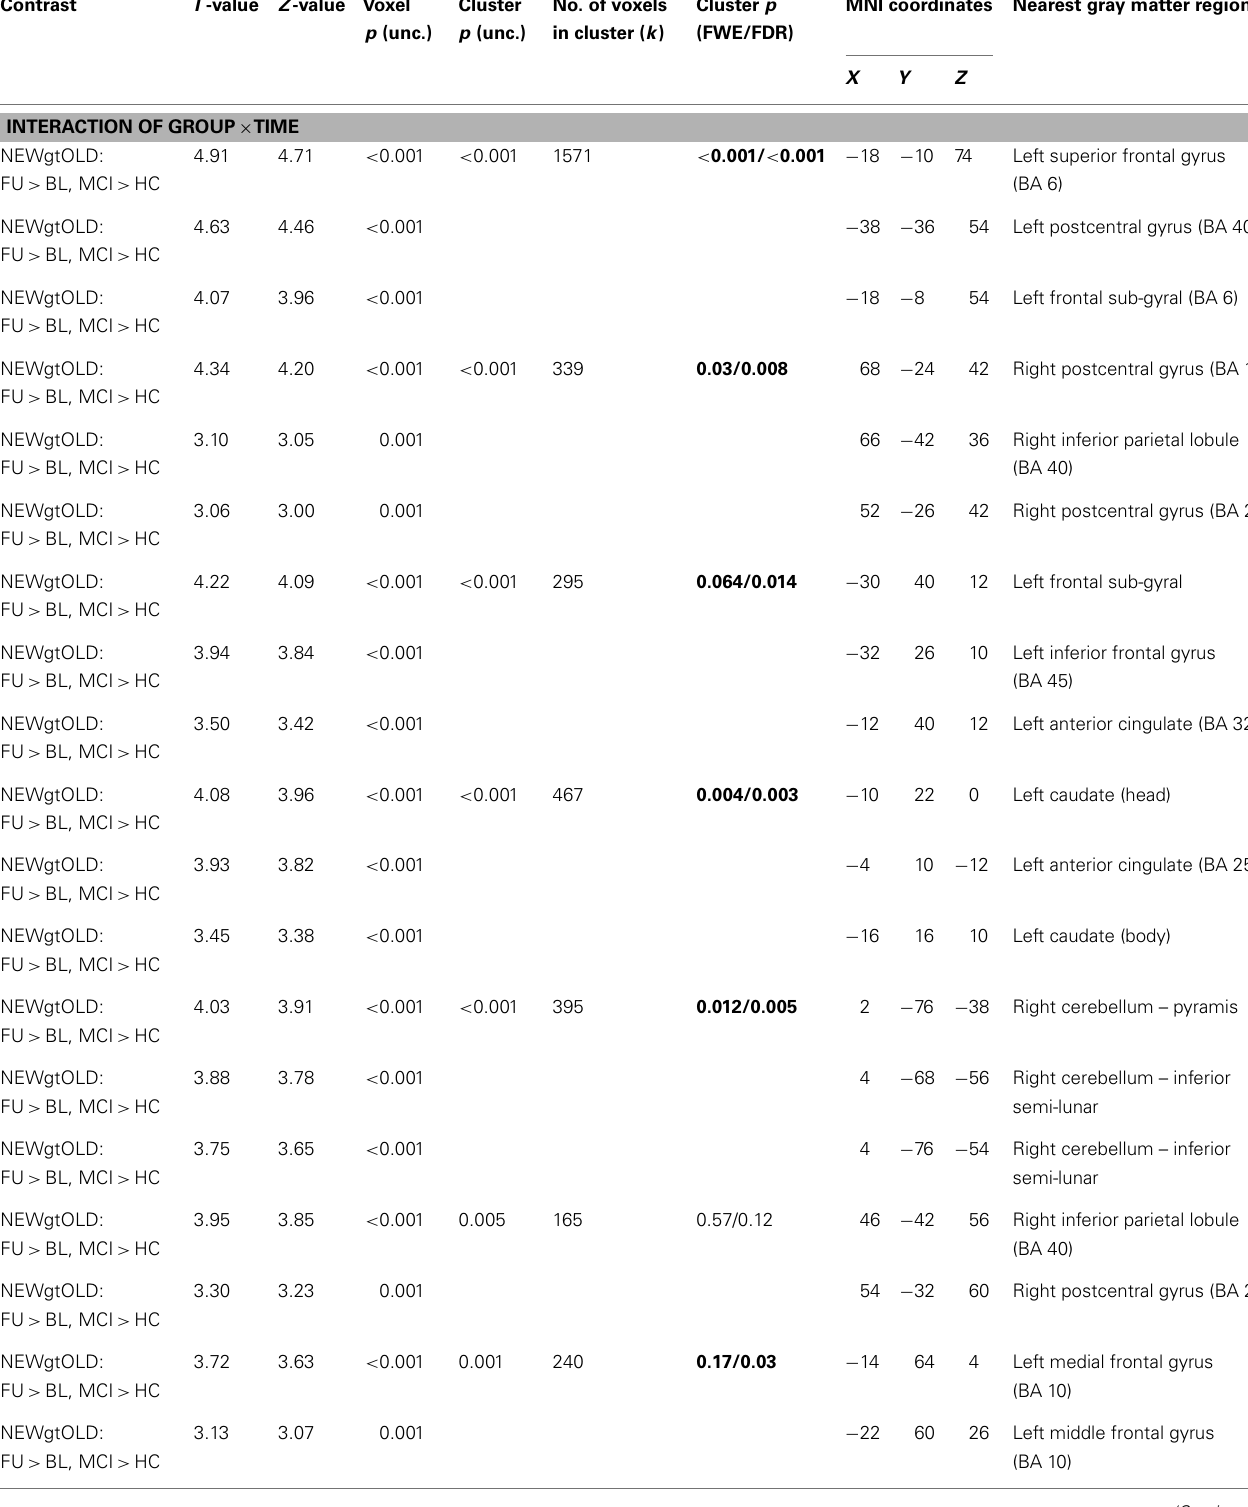
TableA3 |Task-induced functional connectivity during episodic memory encoding (new > old).